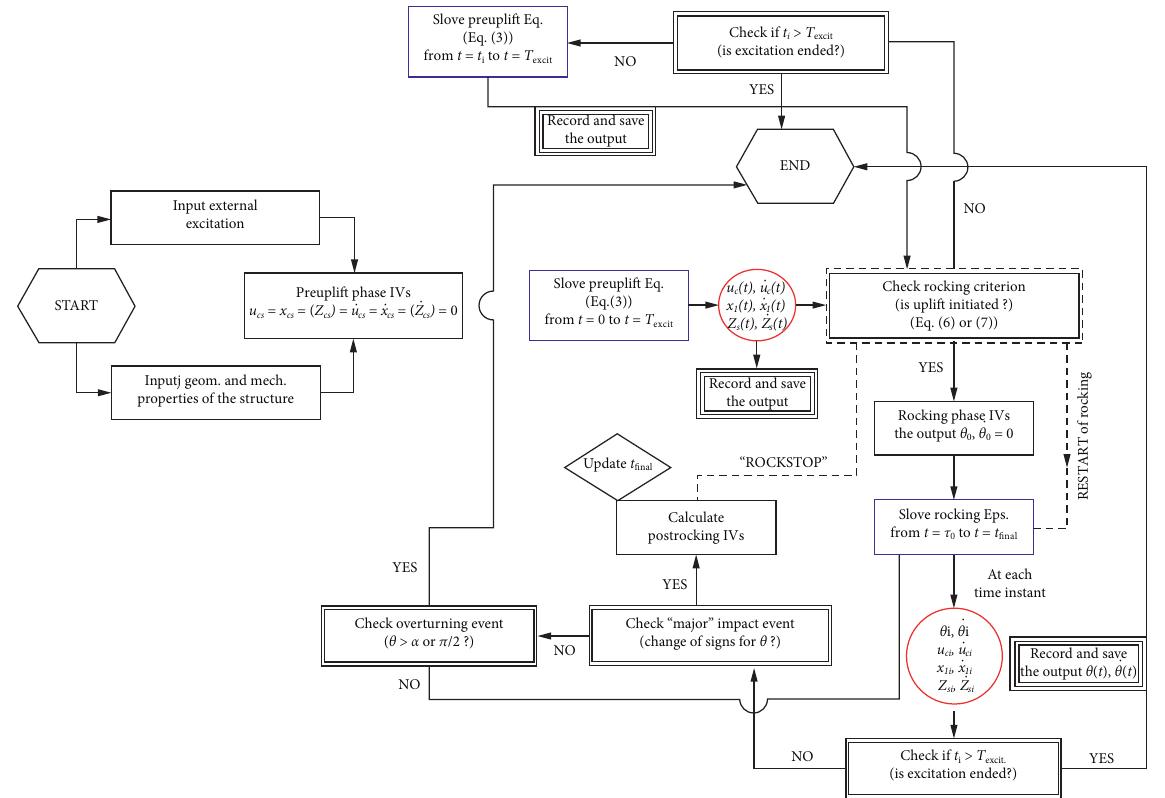
Figure 7: Flowchart of the analysis procedure implemented in